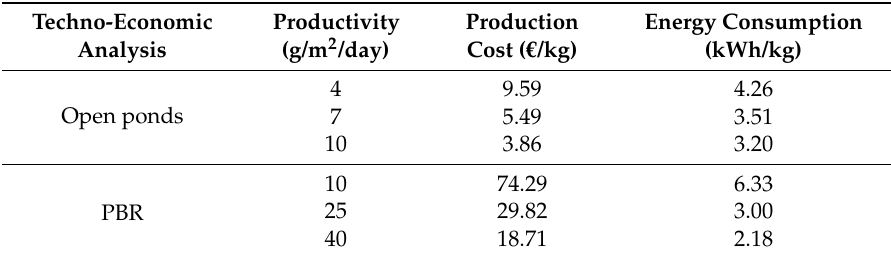
Table 5. Production cost and specific energy consumption for Spirulina cultivation in open ponds and PBR for different